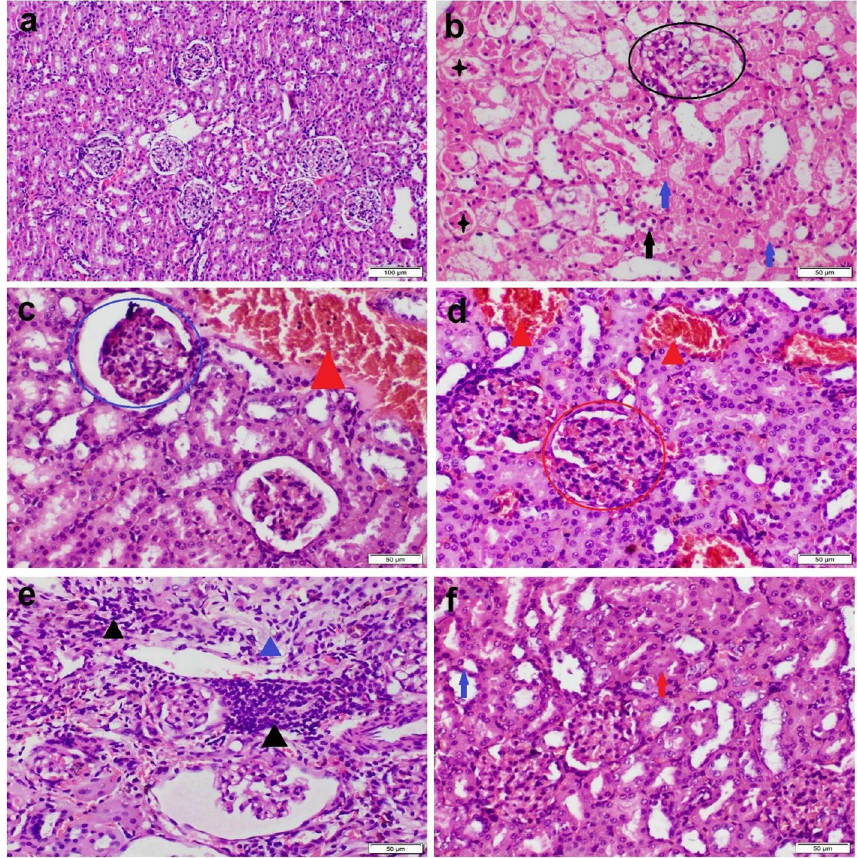
Figure 3. Photomicrograph of kidney tissue sections stained by H&E representing; ( a ) Control group with normal histological structure. ( b – e ) CBZ receiving group showing severe cytoplasmic vacuolization (black arrows) and necrosis (blue arrows) of the tubular epithelium, intraluminal cellular cast (black stars), glomerular degeneration (black circle), widening of the bowmen’s space with atrophy of the glomerular tuft (blue circle), glomerular congestion (red circle), interstitial vascular congestion (red triangle), inflammatory cells infiltration (black triangle), and fibroplasia (blue triangle). ( f ) CS-NPs + CBZ receiving group showing cellular swelling (red arrow) and necrosis (blue arrow) in some tubular epithelium.